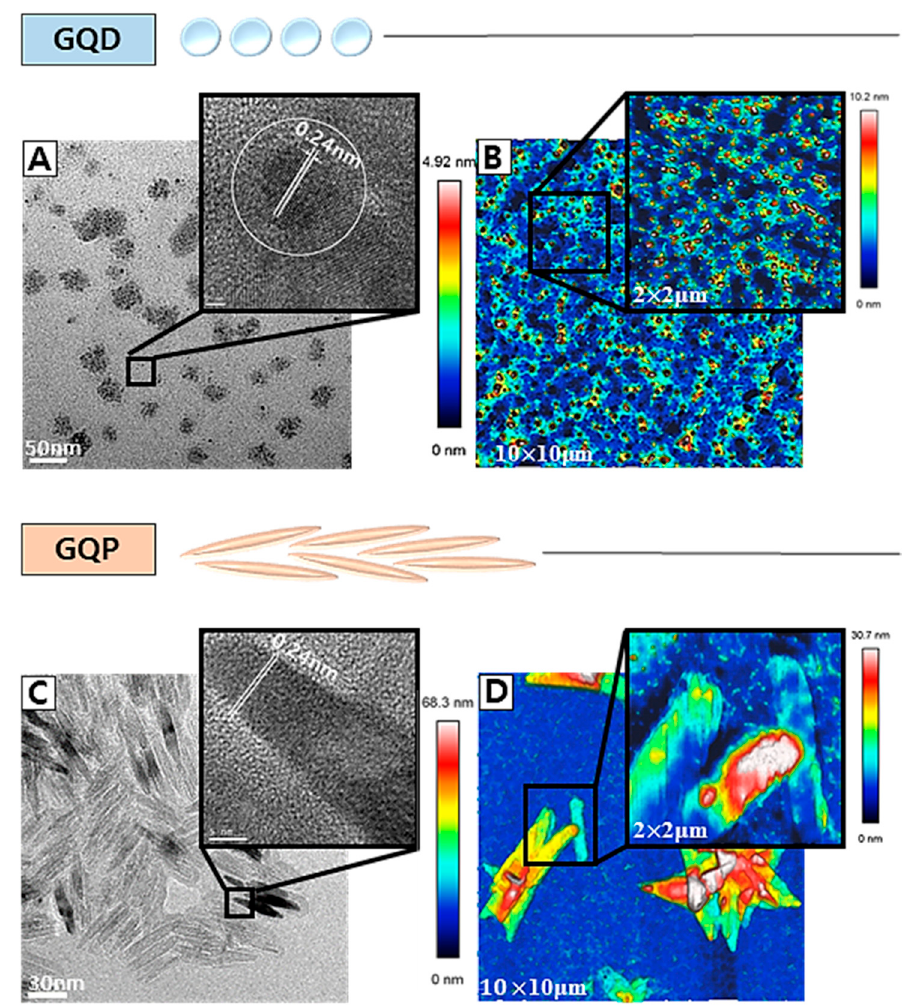
Figure 1. HR-TEM image and AFM image of ( A , B ) graphene quantum dos (GQDs) and ( C , D ) Graphene Quantum Pins (GQPs). The scale bars, 50 nm ( A , C ), 5 nm (inset). HR-TEM images are shown in inset image. ( B , D ) The AFM image show some aggregation of GQDs and GQPs due to electrostatic attraction. The maximum heights are 4.92 nm, 68.3 nm for GQDs and GQPs, respectively.